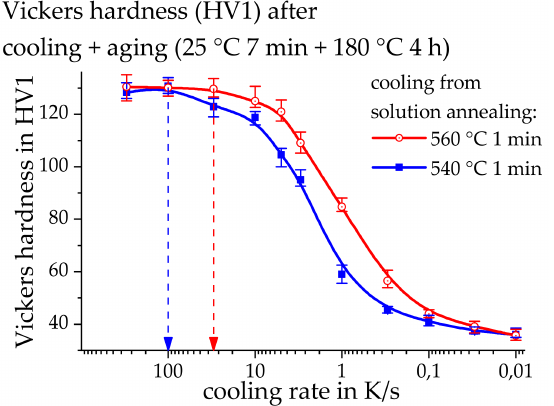
Figure 11. Hardness values (HV1) after cooling and artificial aging, as function of cooling rate, for the following solution-annealing conditions: 540 ◦ C and 560 ◦ C, both with a 1 min soaking time. The upper critical cooling rates (uCCRs) for the two temperatures are indicated by